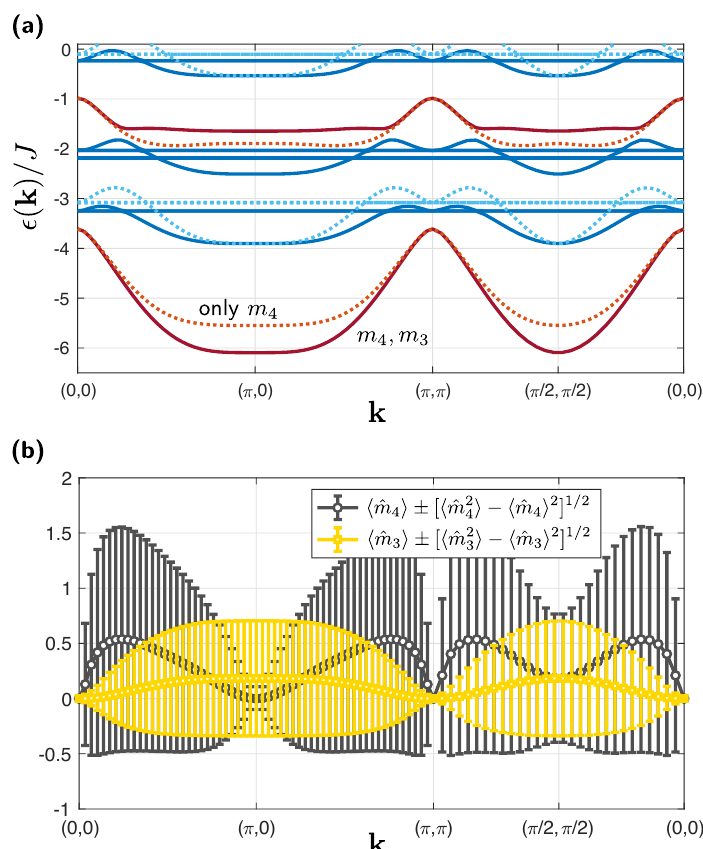
Figure 14: String model results. (a) We show the lowest energy bands predicted by the spinon-chargon model for t / J = 3 and J ⊥ = J . A cut along high-symmetry directions in the Brillouin zone is shown. The full solid lines correspond to the full truncated basis; the light dotted lines correspond to a further truncated basis with ̸ = 0 included. Colors indicate how states connect to rotational (blue) and only m 4 vibrational (red) bands at k = 0 . (b) We show the expectation value and variance (error bars) of the rotational eigenvalues ˆ m (black) and ˆ m (yellow) for the ground 4 3 state of the spinon-chargon model; parameters as in